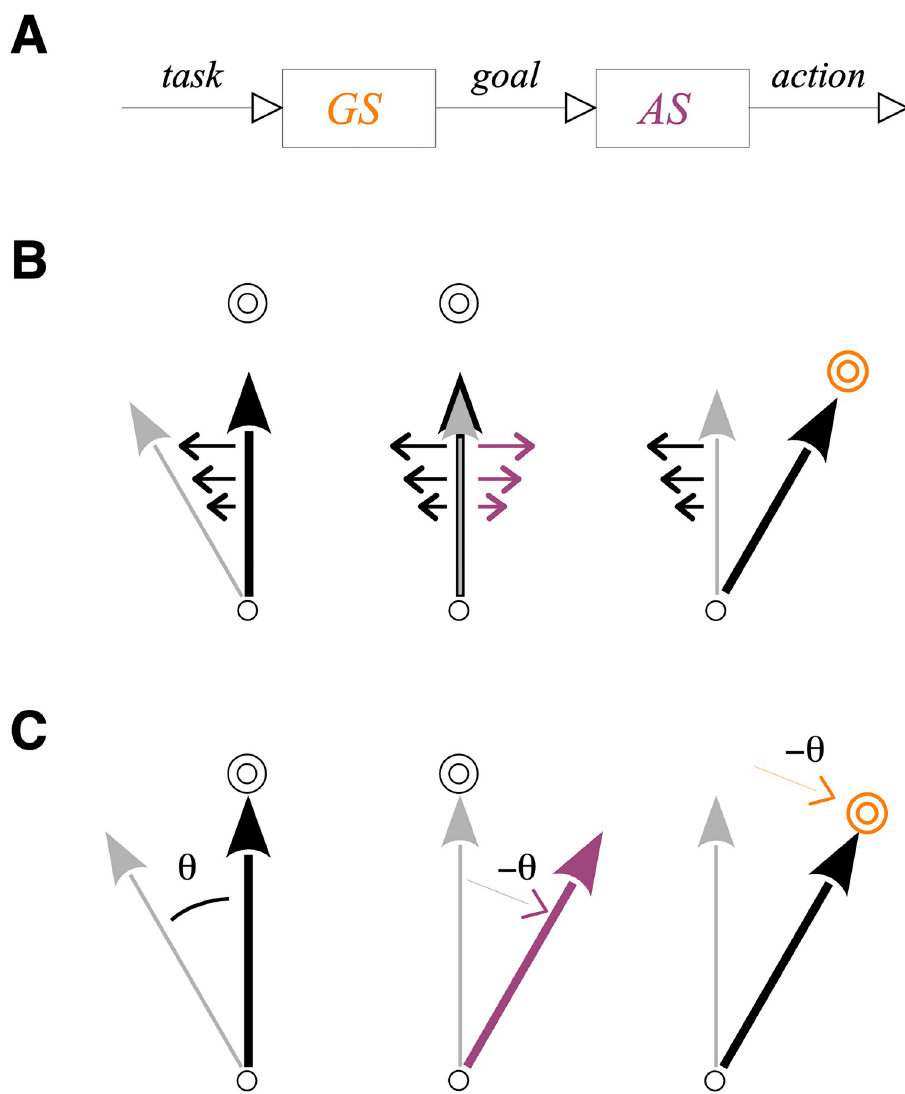
Fig 1. Goal selection vs action selection. A . The motor system contains: (1) a process, called action selection ( AS ; purple ), which translates a current goal (e.g. a target to reach) into the proper displacement of the current effector (e.g. the arm) toward the goal (the target); (2) a process, called goal selection ( GS ; orange ), which provides the current goal for a given task. B . Schematic of adaptation to a force field perturbation (only the early phase of movement is described). The small circle is the starting position, the double circle the goal position, the black arrow the planned displacement, and the gray arrow the actual (or observed) displacement. ( left ) For a planned displacement toward the goal position, the force field ( black leftward arrows) induces an initial actual displacement in the direction of the perturbation. ( center ) Adaptation at the AS level consists in keeping the same goal position and applying compensatory forces ( purple rightward arrows). ( right ) Adaptation at the GS level consists in re-aiming toward a new goal position ( orange double circle). C . Schematic of adaptation to a rotation of the visual display. ( left ) For a planned displacement toward the goal position, the rotation induces an initial actual displacement in the direction of the rotation. ( center ) Adaptation at the AS level consists in keeping the same goal position and applying compensatory rotation (purple rightward arrow). ( right ) Adaptation at the GS level consists in re-aiming toward a new goal position ( orange double